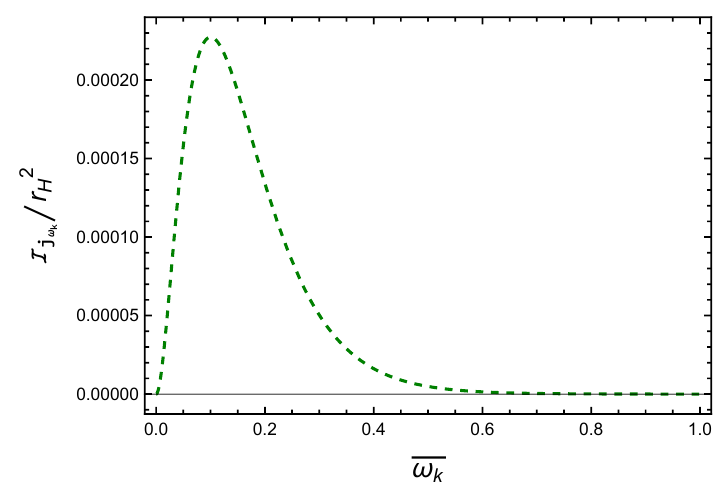
is plotted for two outgoing null detectors in a (1 + 1) dimensional /r 2 H ωk ∆ E A = 0 . 5 , ∆ E B = r H